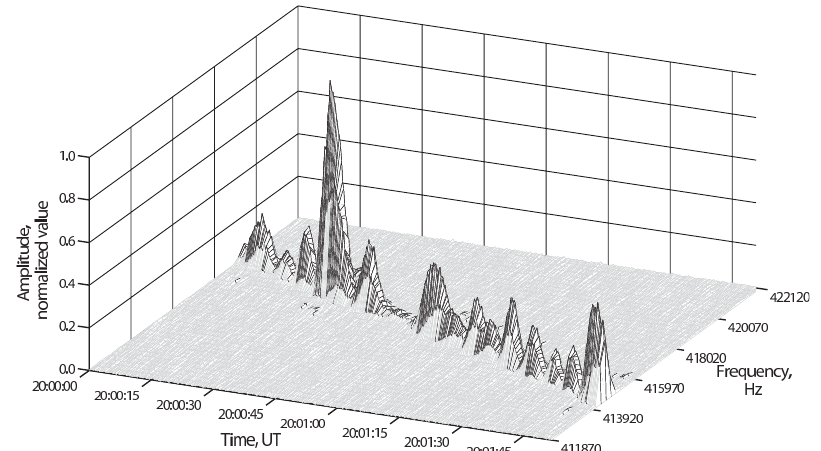
Fig.4. The amplitude of power spectrum as the function of time and frequency. Integration time: 0.25 s. Irbene, 2013 February 15.